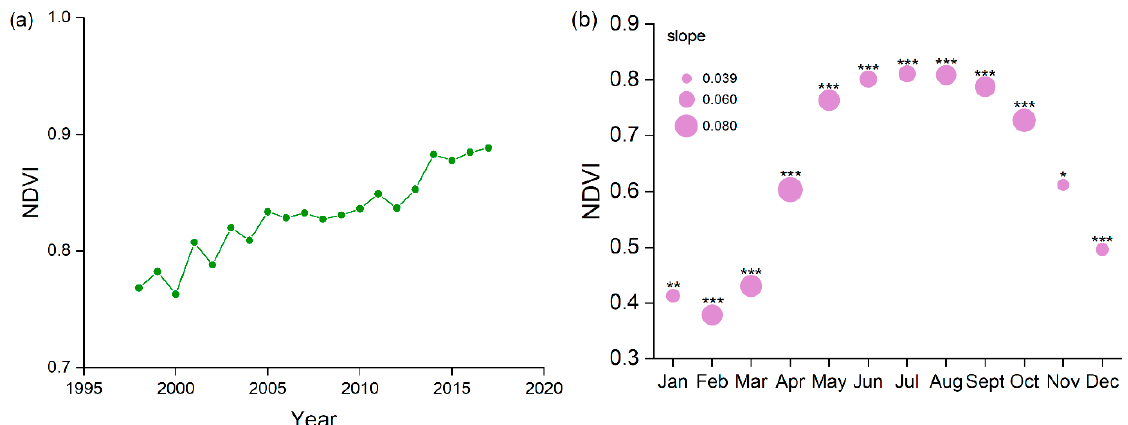
Figure 5. Variations in the NDVI in the Daning River basin: ( a ) average annual NDVI from 1998 to 2017; ( b ) monthly variation in the NDVI and Sen’s slopes. * Significance at 10% level; ** significance at 5% level; *** significance at 1% level.